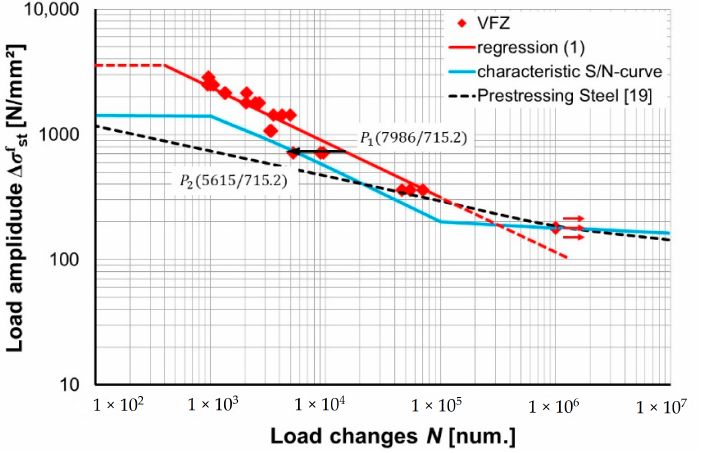
Figure 6. Mean and characteristic S/N curve of high-strength micro steel fibres.